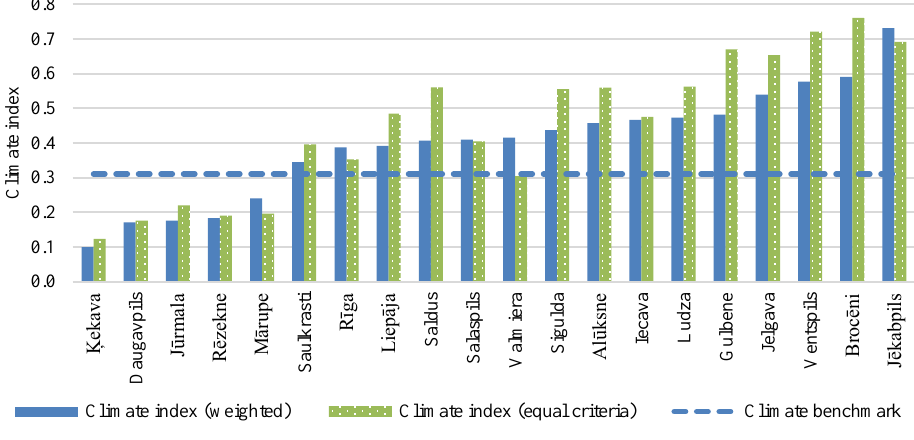
Fig. 7. Results of ranked Climate index values and obtained climate